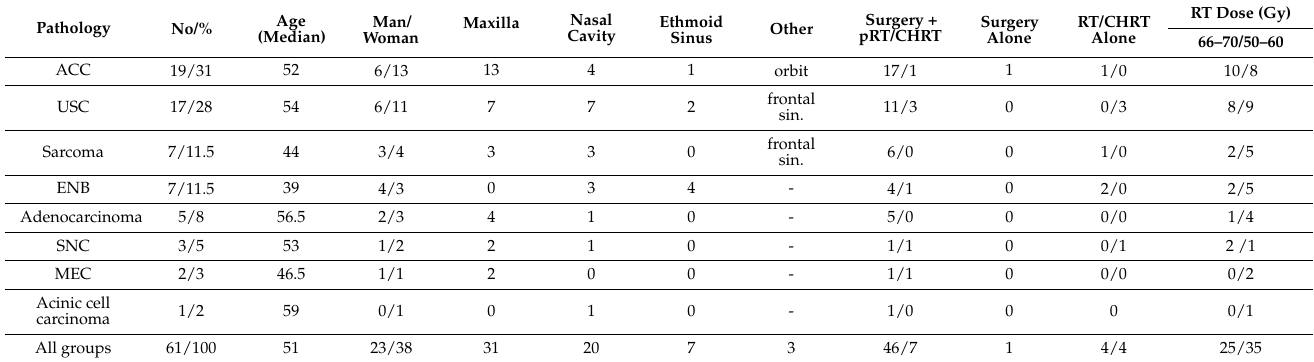
Table 1. Patients’ characteristics according to histopathological types and in all groups. ACC— adenoid-cystic carcinoma, USC—undifferentiated sinonasal carcinoma, ENB—olfactory neuroblas- toma, MEC—mucoepidermic carcinoma, and SNC—small cell neuroendocrine carcinoma. CHRT— radiochemotherapy.